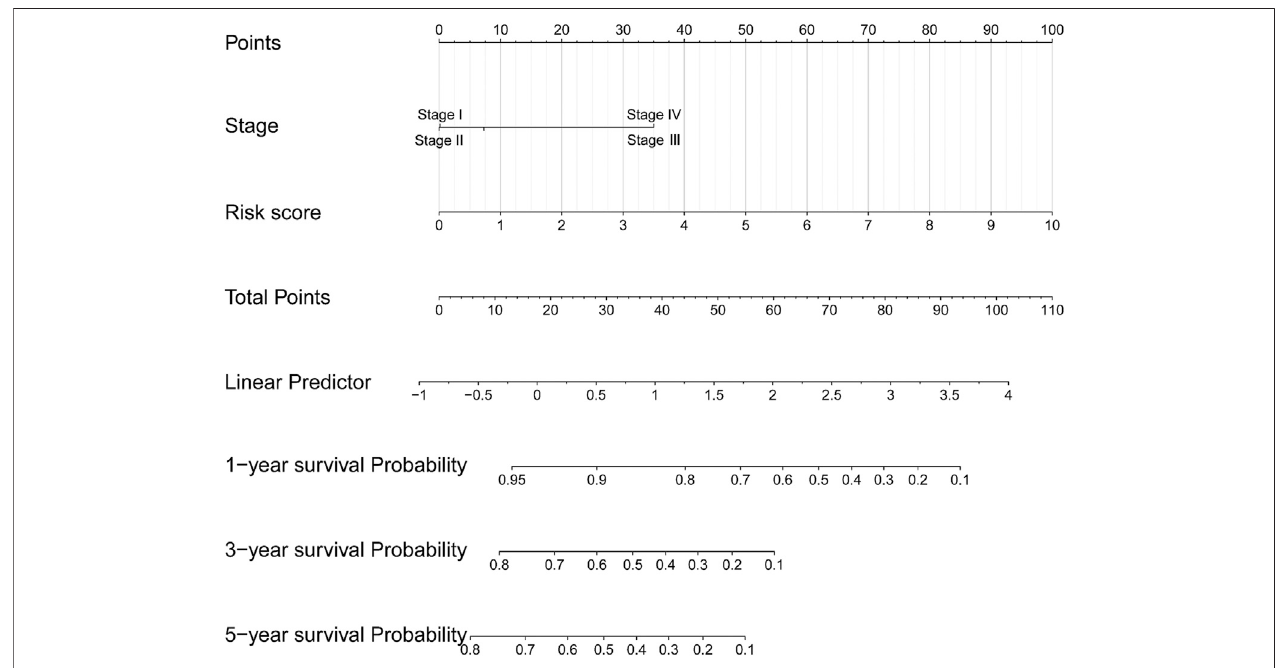
FIGURE 5 | A nomogram incorporating 5-immune-gene signature and clinical stage was constructed for predicting OS of CSCC patients.